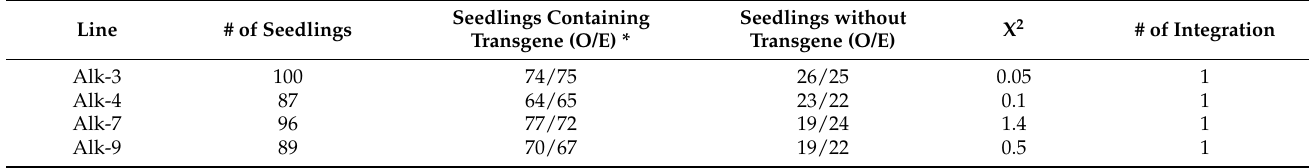
Figure 1. The presence (or absence) and the level of expression of the alkaline protease gene in T0 transgenic leaf tissues. ( A ) PCR confirmation of the presence (+) or absence ( − ) of the alkaline protease gene ( alk ) in pTF102-Alk-RNAi vector transformed T0 leaf tissues. pTF102-Alk-RNAi plasmid DNA was used as a positive control, and the genomic DNA from maize line B104 was used as a negative ( − ) control. ( B ) Expression of the alk transgene in the T0 leaf tissue of various transformation events relative to the maize 18S rRNA using real time PCR. Alk-1, Alk-5, Alk-8 and Alk-12 are negative for the transgene. Events labelled with the same letters are not significantly different at p ≤ 0.05. Table 2. Alk gene copy number analysis based on genotyping of seedlings developed from self-pollinated T3 generation ears and chi-square